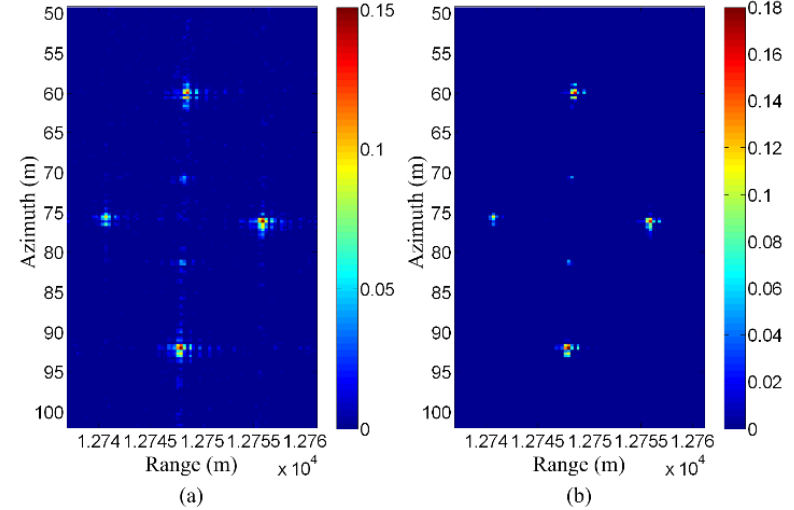
Figure 16. Observation position error compensation for airborne SAR data. ( a ) Result without observation position error compensation. ( b ) Result with observation position error compensation (taken from [84]).